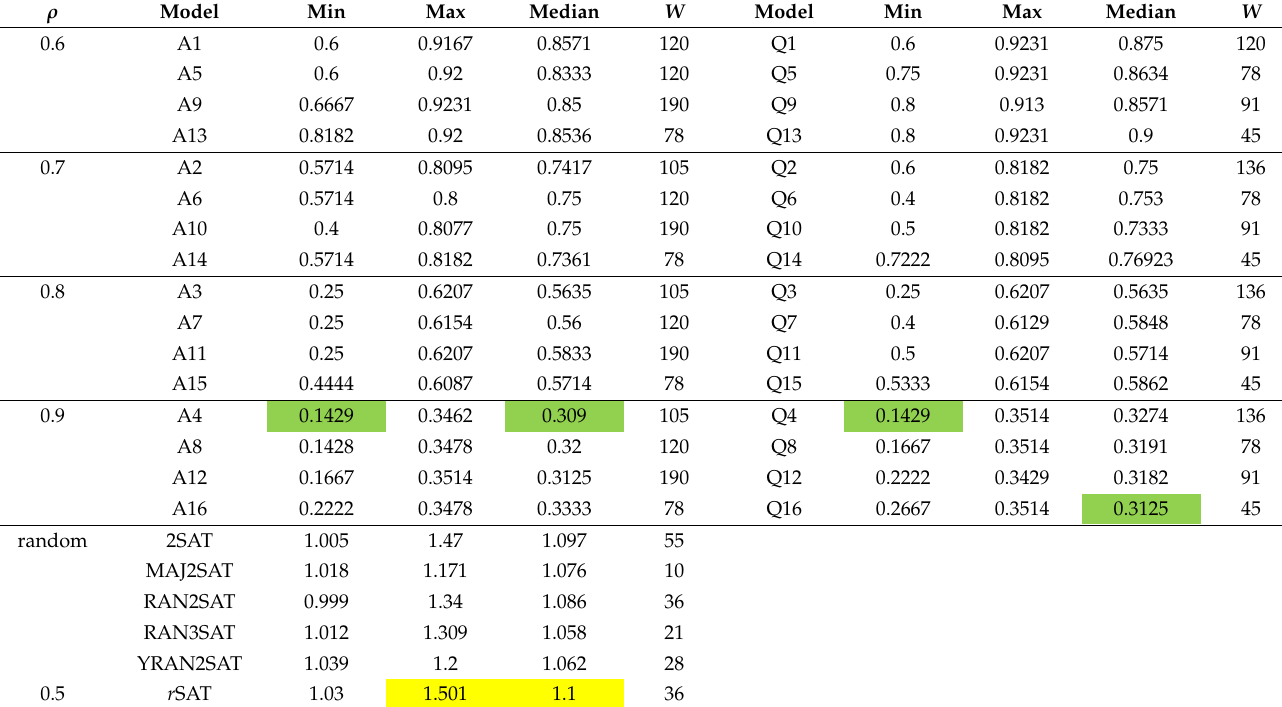
Table 9. Maximum and minimum NAE results for models with both types of logic δ 1 2 SAT ρ , δ 2 2 SAT ρ , and recently developed logic systems with details determined by Wilcoxon test for median divided by ρ